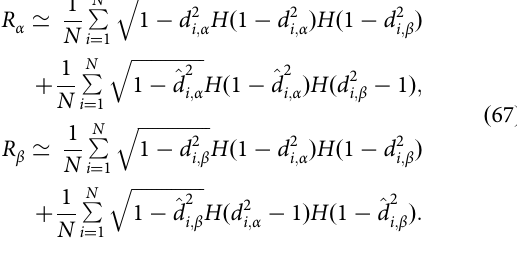
ffiffiffiffiffiffiffiffiffiffiffiffiffiffiffi